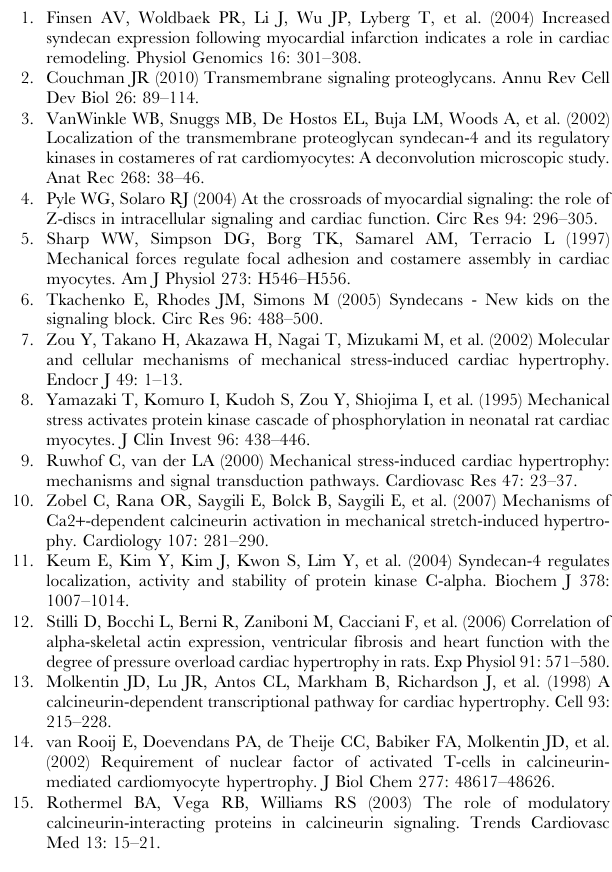
Figure S3 Epitope mapping of syndecan-4 antibodies. Synde- can-4 residues important for antibody binding were identified by overlaying an array of immobilized syndecan-4 20-mer peptides with (A) anti-syndecan-4, (sc-15350), (B) anti-syndecan-4 ( # 1420), can-4-HRP ( # 41144). Underlined and bold amino acids indicate amino acid sequence SIRETEVIDPQDLLEGRYFSGALPDD located to the N-terminus of syndecan-4 consistent with the source information from the producer (Santa Cruz) (n= 1). (B) Anti-syndecan-4 ( # 1420) strongly and specifically recognized the amino acid sequence KDEGSYDLGKKPIYKKAPTNEFYA located to the cytoplasmic part of syndecan-4. Further mapping revealed that the core epitope was located to the V-region in syndecan-4 (underlined sequence in B) (n= 3). Both pS179- syndecan-4 antibodies (sc-22252-R, (n= 2) and # 41144 (n= 3)) recognized pS179-syndecan-4 strongly (right panels in C and D, respectively) compared to the non-phosphorylated syndecan-4 (left panels). Consistent with our findings and according to Genscript,